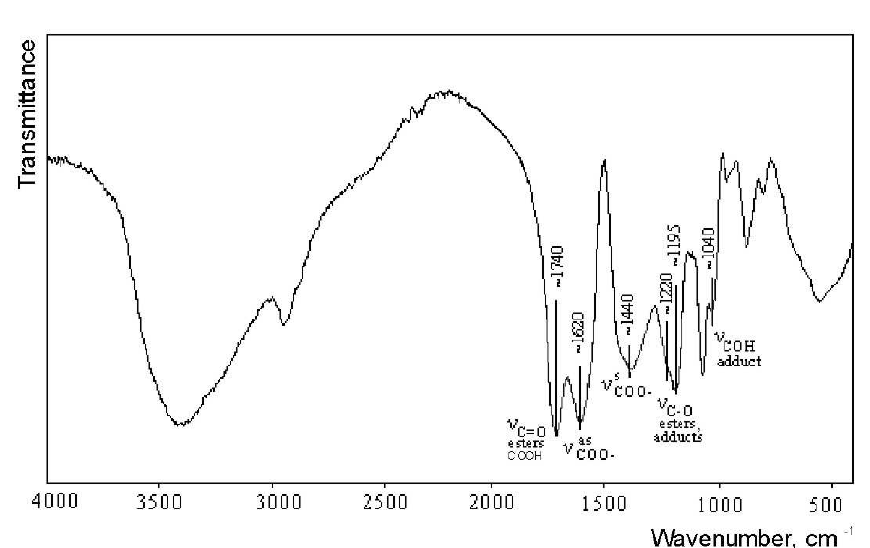
Fig. 1 IR spectra of Y-Al- citric